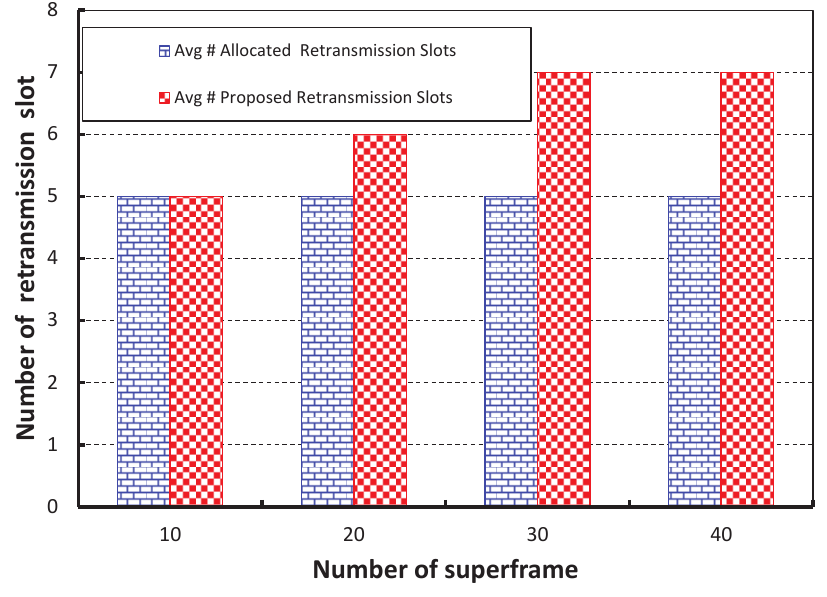
Figure 14. Optimal number of retransmission slots for different numbers of